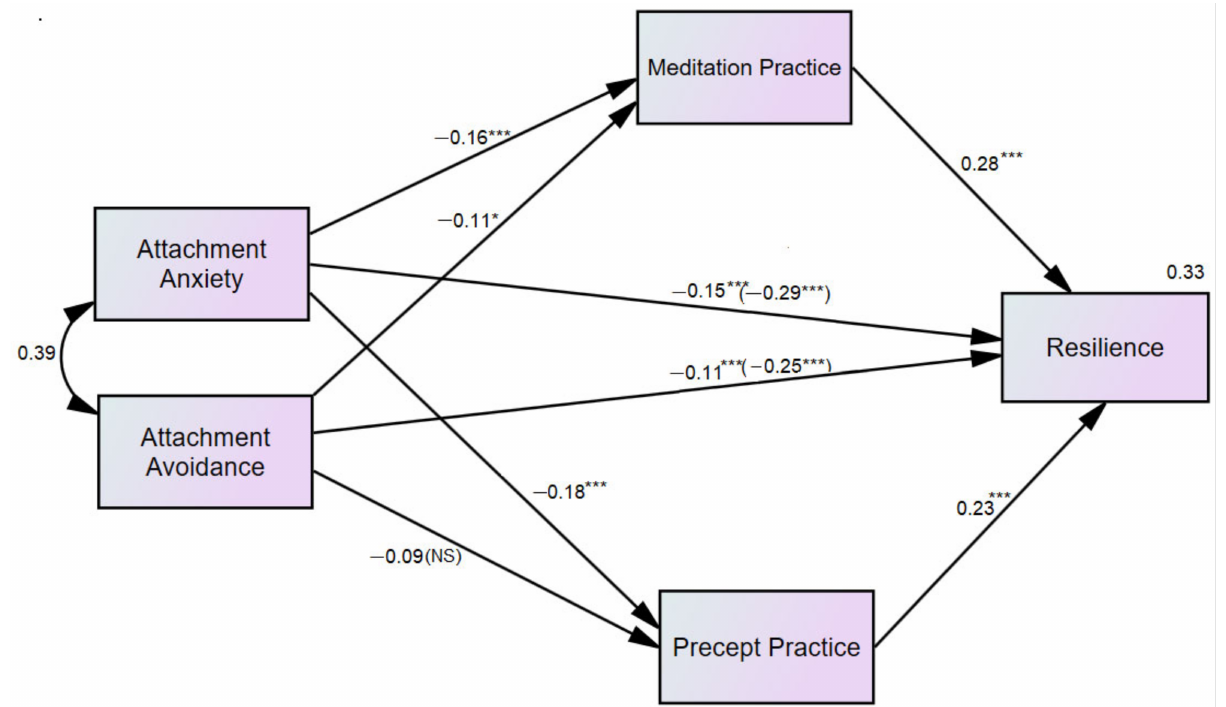
Figure 2. Parallel mediation model ( n = 453). Indirect effects of attachment anxiety/attachment avoidance on resilience through meditation and precept practice (controlling for covariates). The model is controlled for age, sex, school type, religion, and family income. Standardized effects are presented. The effects on the direct path from attachment to resilience depict the direct effect and the (total effect) * p < 0.05, *** p < 0.001, NS =